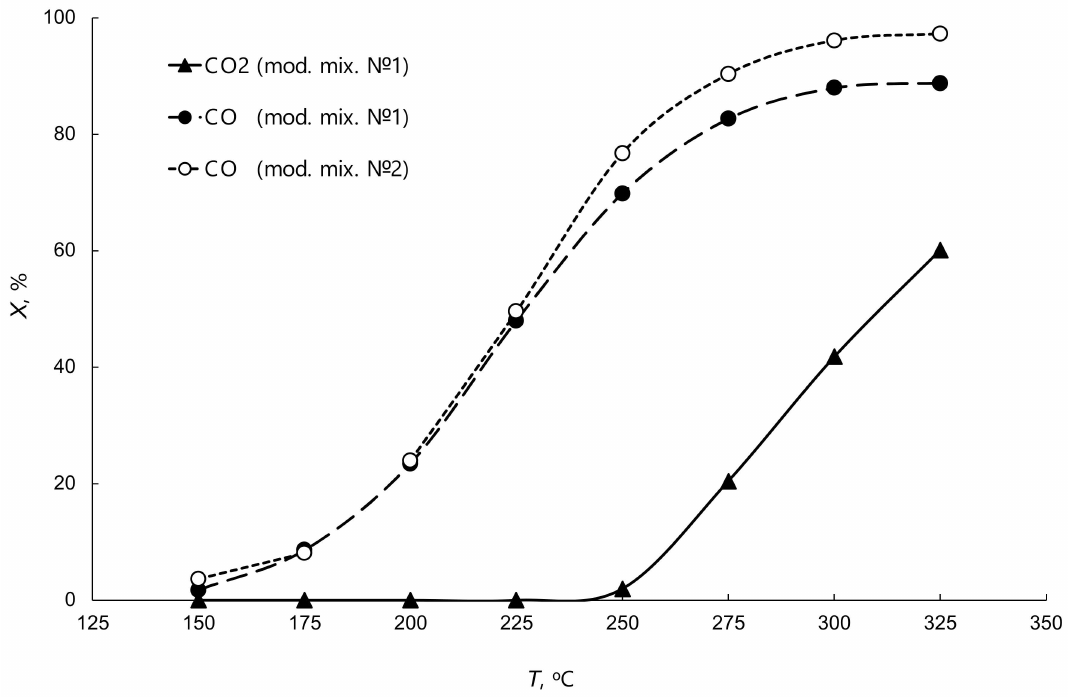
Figure 14. Temperature dependence of the conversion of carbon oxides in the process of hydrogena- tion of model mixtures identical in composition to the gaseous products of ethanol steam